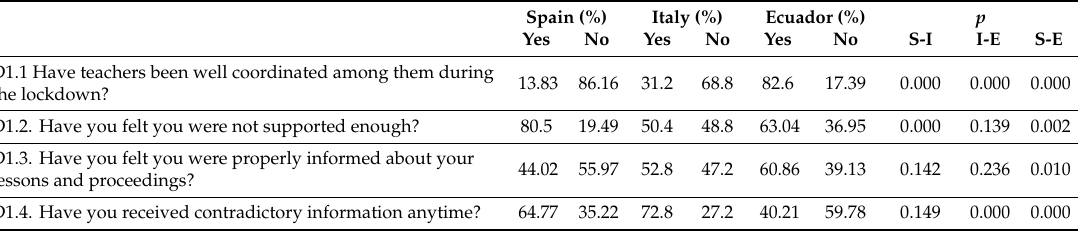
Table 2. Di ff erences among countries for D1 and basic statistics (N = 376). Spain (%) Italy (%) Ecuador (%) p